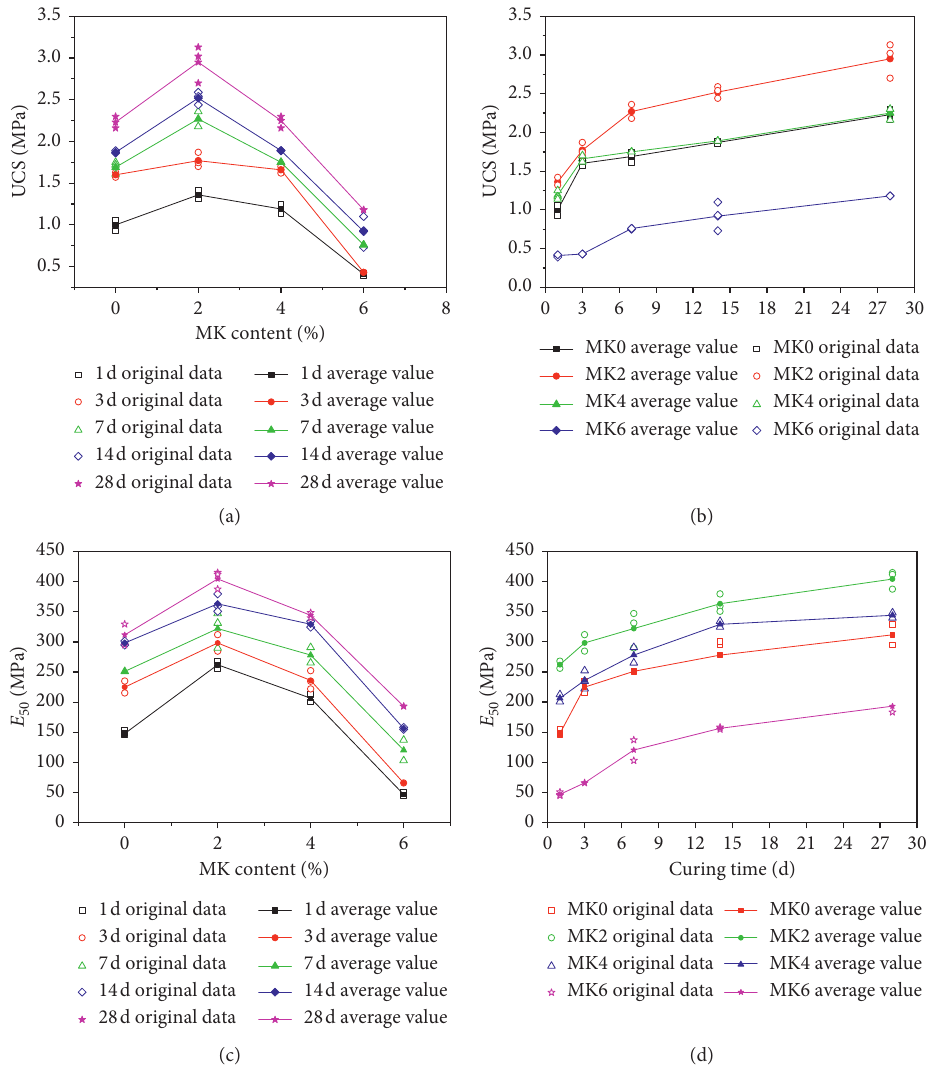
Figure 3: UCS and E 50 test results of MK-cemented silty clay. (a) UCS at different MK contents, (b) UCS at different curing times, (c) E 50 at different MK contents, and (d) E 50 at different curing